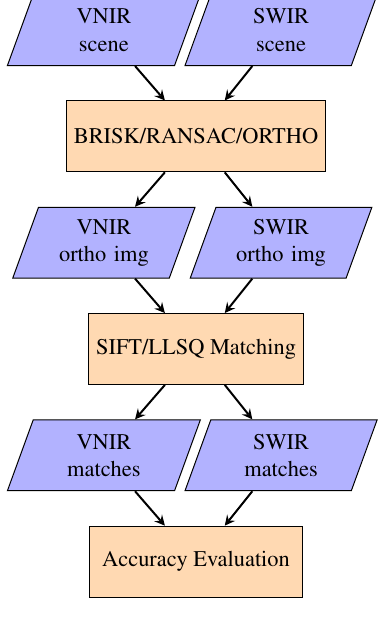
Figure 6: Evaluation approach